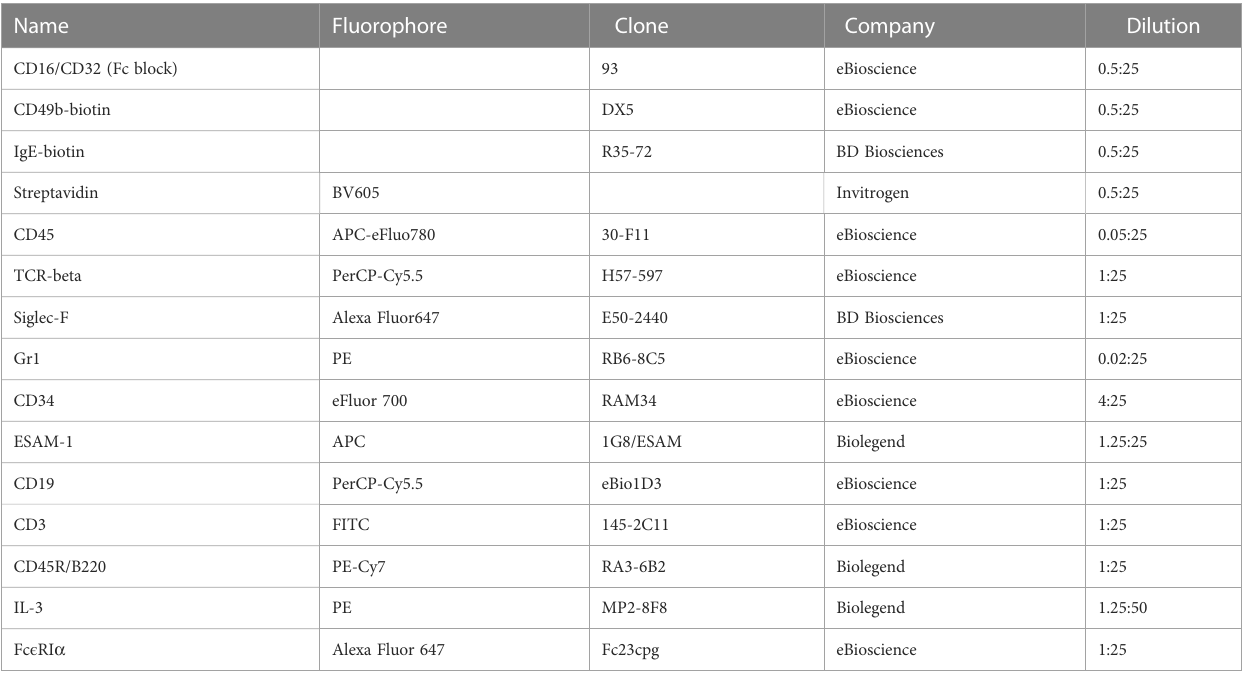
TABLE 1 Antibodies used for Flow cytometry. Name